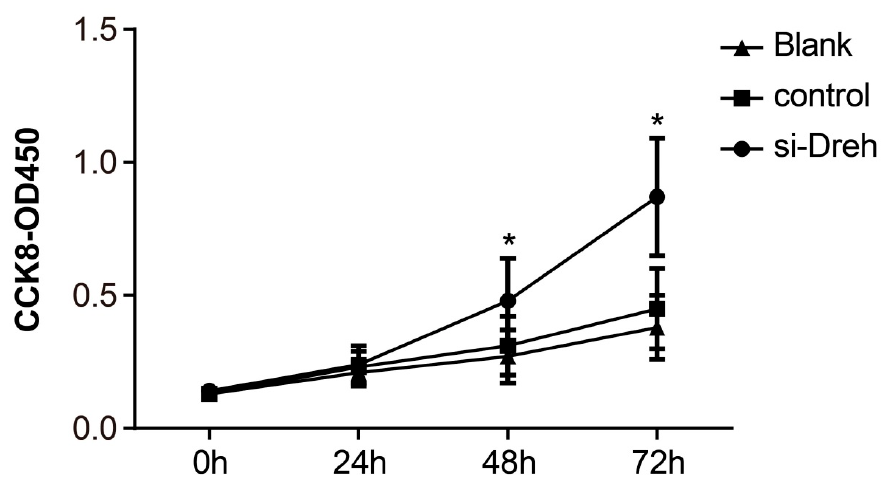
Figure 4. The WB-F344 cells proliferation is elevated after silencing of LncRNA-Dreh. * p < 0.05, vs. the blank and control groups. Cells without any transfection were used as the blank group, cells with blank plasmid transfection were used as the control group. The results are given as means ± SD ( n = 3 samples). Enumeration data were performed according to ANOVA with chi-square test ( p < 0.05). 2.5. Silencing of LncRNA-Dreh Promotes Migration of HPCs